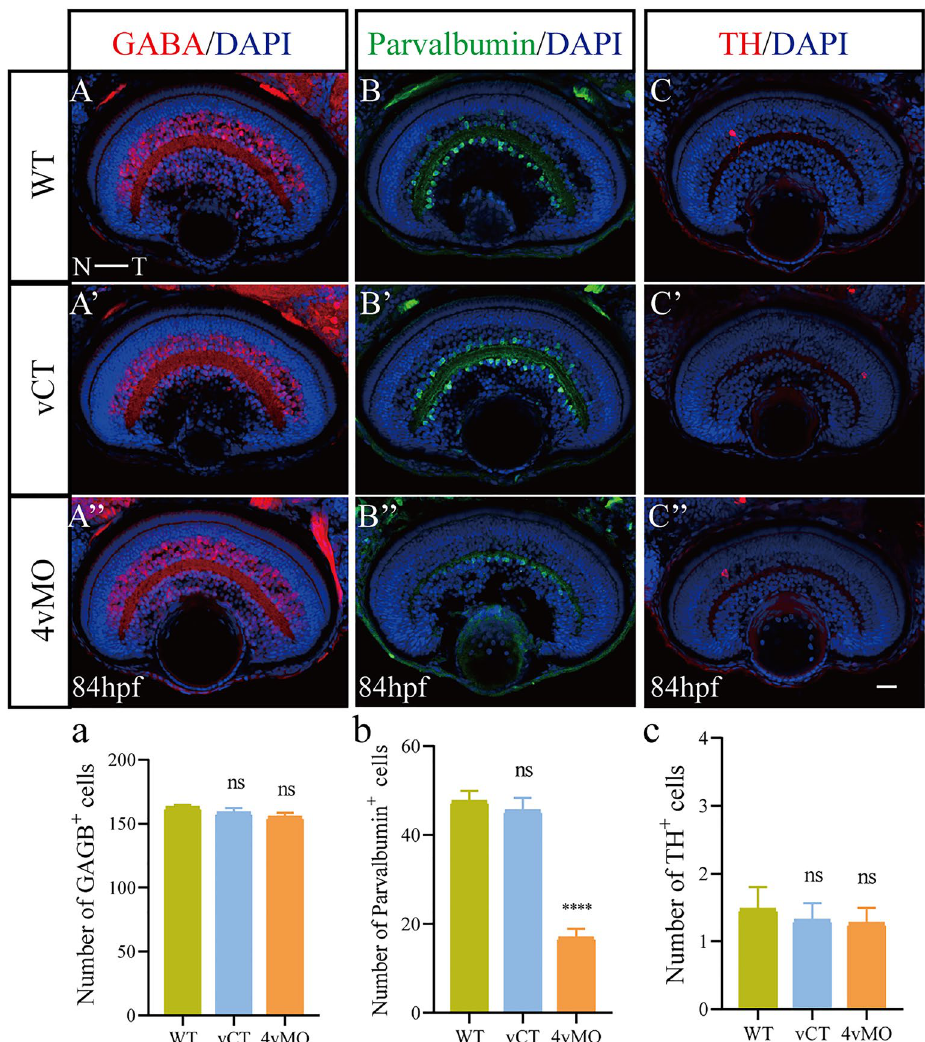
Figure 2. Effects of lhx4 knockdown via vivo - MO in the eyes on the ACs differentiation. All figures are horizontal sections along the temporal-nasal axis (T-N). ( A – C’’ ) Immunofluorescence staining with different ACs markers, GABA, Parvalbumin, and Calretinin in WT, vCT, and 4vMO retinas at 84 hpf. Blue, DAPI staining of the nuclei. Scale bar = 20 μm. ( a – c ) Statistical analysis of GABA + , Parvalbumin + , and Calretinin + cells in WT, vCT, and 4vMO retinas at 84 hpf. ns, P > 0.05; ****, P < 0.0001; vCT vs. WT; 4vMO vs. vCT. Results are presented as the mean ± SEM (n ≥